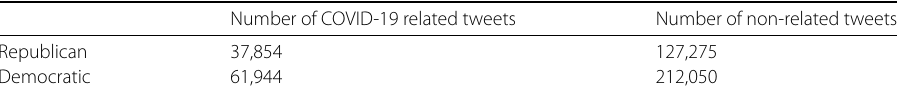
Table 2 The number of COVID-19 related tweets and non-related tweets for each